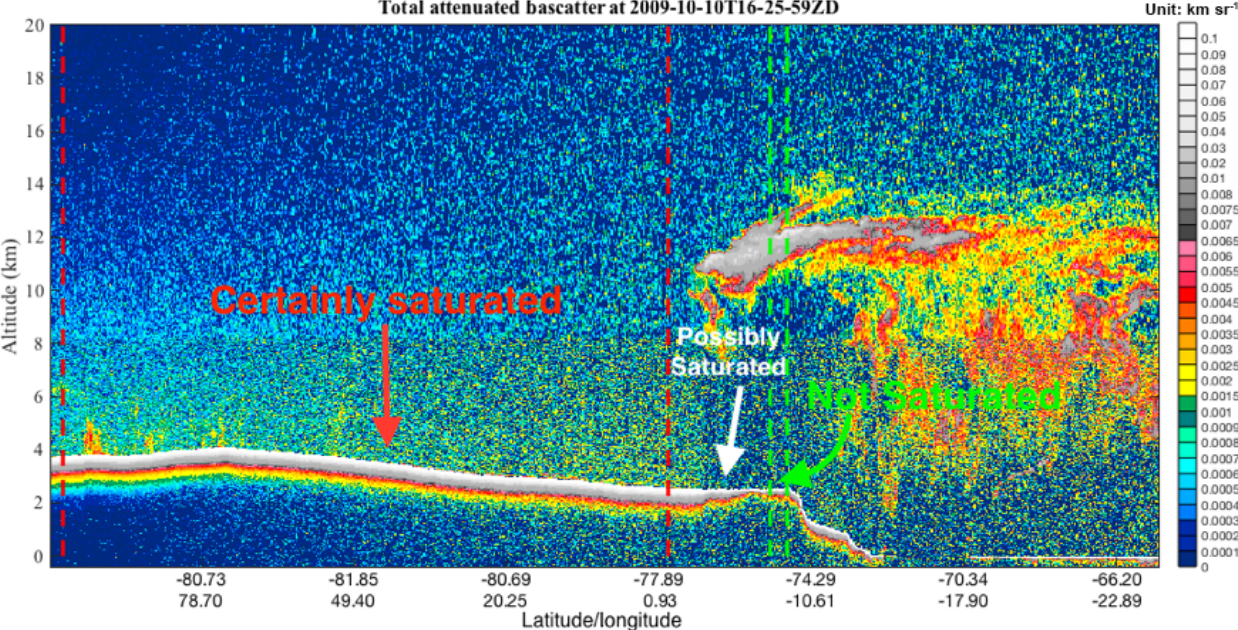
Figure 6. Total attenuated backscatter at 532nm (km − 1 sr − 1 ) on 10 October 2009; the surface return signals between the red dashed lines under clear sky are certainly saturated, while the signals between the green dashed lines under transparent cloud are not saturated. The surface signals between the red and green dashed lines under transparent cloud are possibly saturated. The color bar on the right indicates the value of total attenuated backscatter.